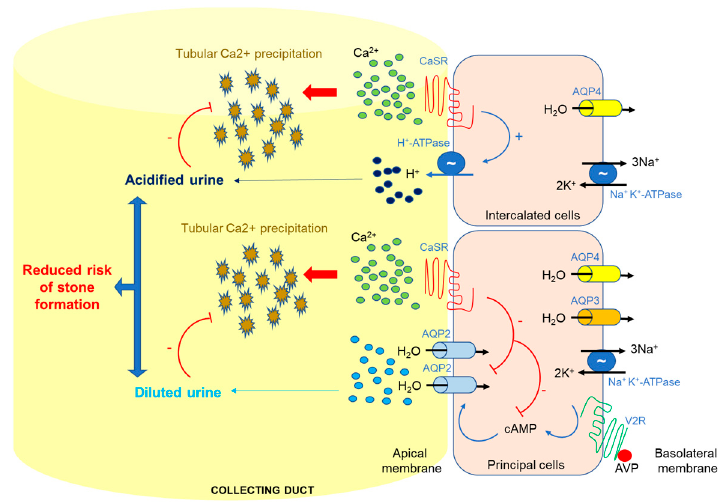
Figure 2. Localization and function of CaSR in the collecting duct. In the presence of an antidiuretic stimulus, Ca 2+ concentrations in the pre-urine can become super-saturating, potentially leading to Ca 2+ stone formation. When the luminal Ca 2+ concentration becomes critically high it activates the apical CaSR which, in principal cells, blunts vasopressin-mediated apical insertion of the aquaporin-2 (AQP2) water channel and the rate of water reabsorption. In intercalated cells, CaSR activation leads to luminal acidification. Overall, these two effects result in the production of a dilute, acidified urine, which reduces the risk of nephrolithiasis.